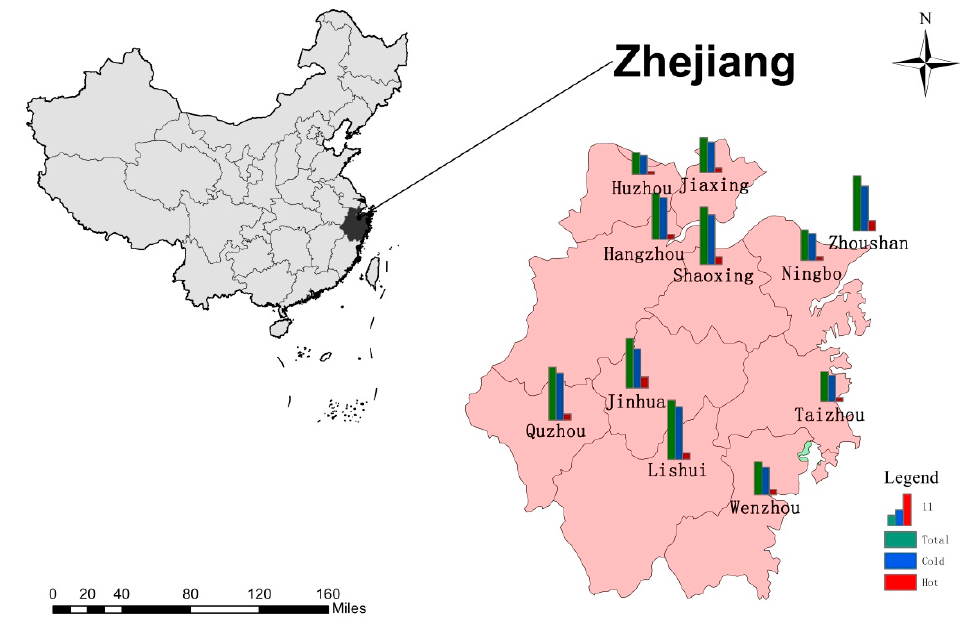
Figure 1. The location of 11 cities in Zhejiang Province and the attributable fraction of cardiovascular disease (CVD) deaths, which were divided into cold and hot temperatures based on distributed lag non-linear model. Cold and hot effects were defined by the minimum mortality temperature. This map was formed by ArcGIS software, Version 10.1, Esri, Redlands, CA,